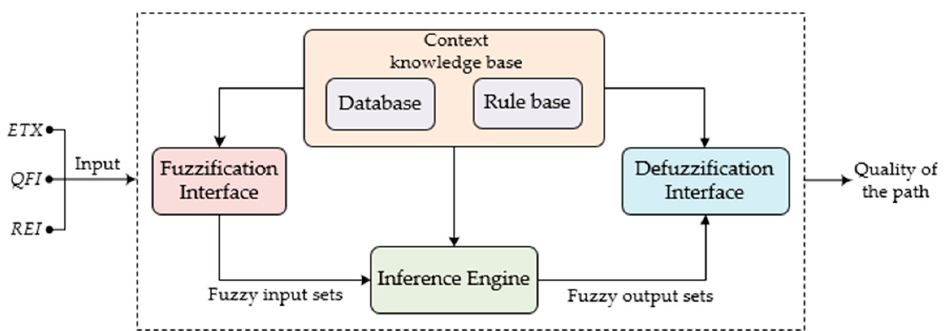
Figure 8. Fuzzy system based path selection structure.